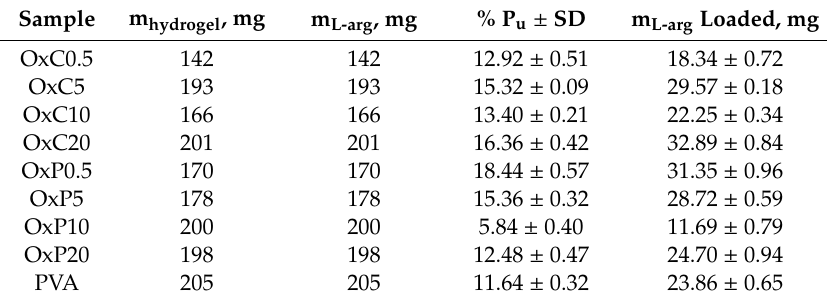
Table 1. L-arginine hydrogel loading.